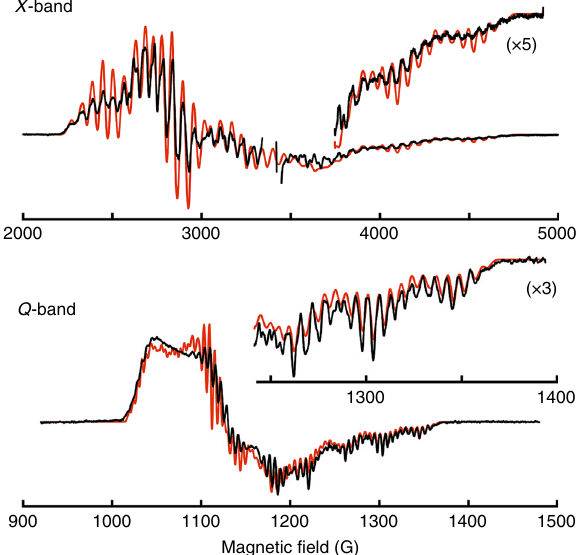
Fig. 4 EPR spectroscopy. Continuous-wave EPR spectra of 1 . as frozen solution obtained at X -band (9.634 GHz) and Q -band (34.202GHz) in black with simulated spectra in red. High- fi eld regions of each spectra are expanded as insets. g = [ g 1 , g 2 , g 3 ] = [2.298 2.114 1.967], A ( 121 Sb) = [ A 1 , A 2 , A 3 ] = [ − 385, − 496, 1138] MHz and 2 × A ( 69 Ga) = [132, 176, 134] MHz, lw (peak – peak) = 2.0 G. X -band conditions: temperature 15 K; modulation amplitude = 6 G; modulation frequency = 100 kHz; time constant =